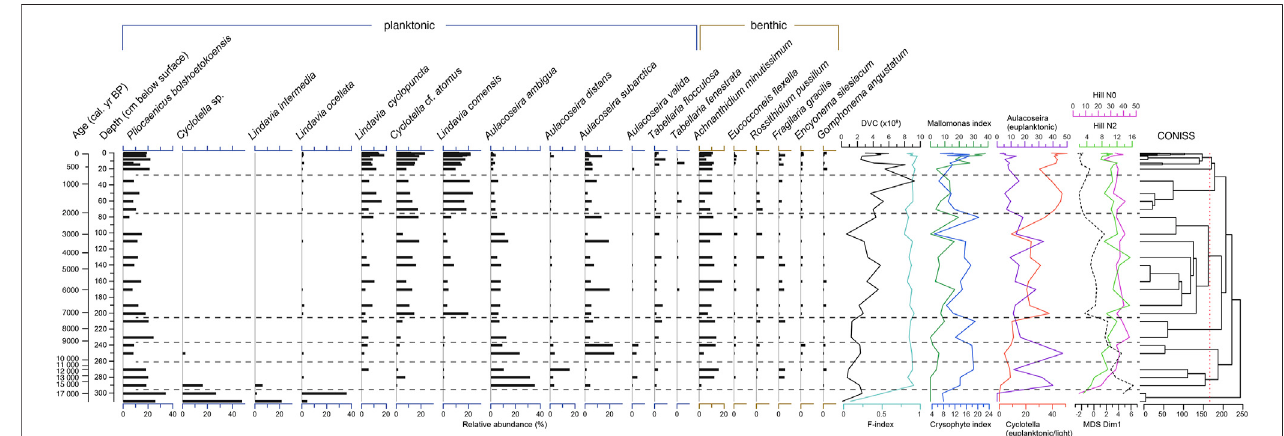
FIGURE5| Relativeabundanceofdiatomspecies,diatomvalveconcentration, Mallomonas andCrysophyteindices,andsumsofselectedplanktonic Aulacoseira and Cyclotella (sensu lato) taxa. Zonation guided by CONISS. Values are plotted next to composite core depth and median age values from the Bacon model. The species shown represent taxa present with ≥ 2.5% in ≥ 2 samples including the bottom sample.